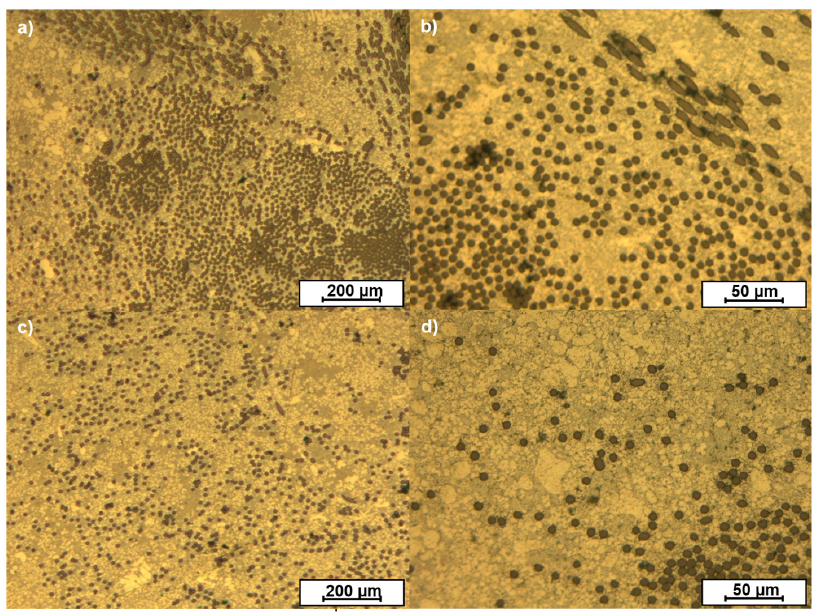
Figure 3. Optical micrographs of the AMCs: ( a , b ) samples manufactured with woven, and ( c , d ) samples manufactured with unidirectional fiber.